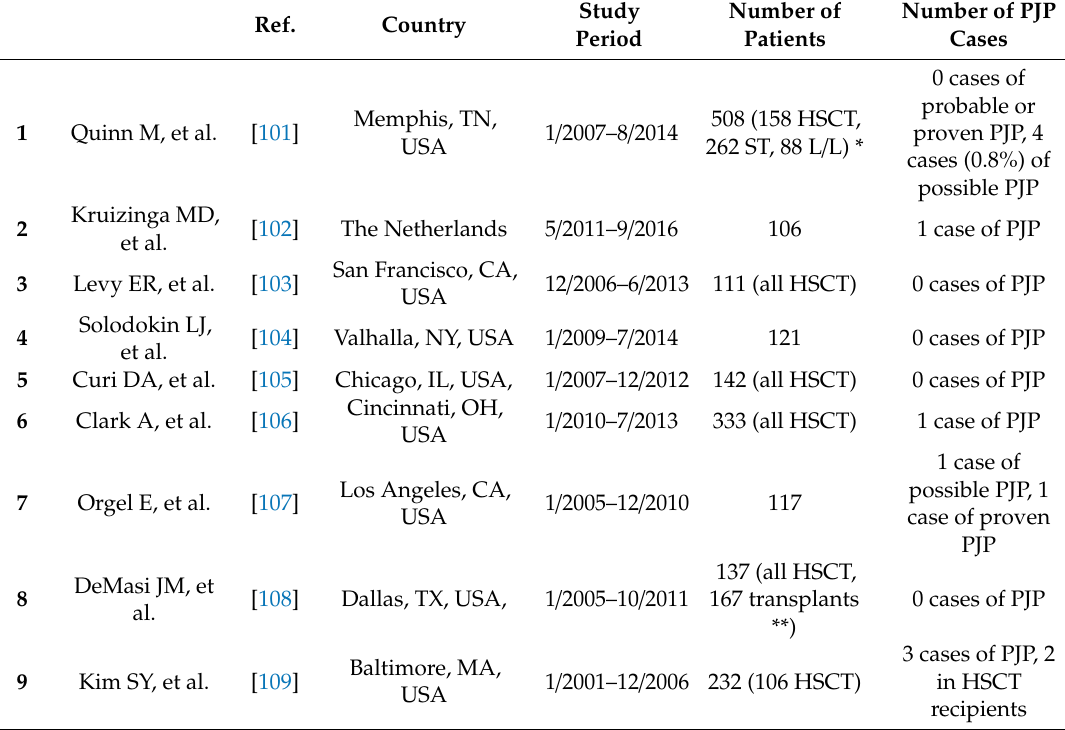
Table 2. Series of pediatric patients with malignancies or who underwent hematopoietic stem cell transplantation (HSCT) and received pentamidine intravenously for PJP prophylaxis. Ref. Country